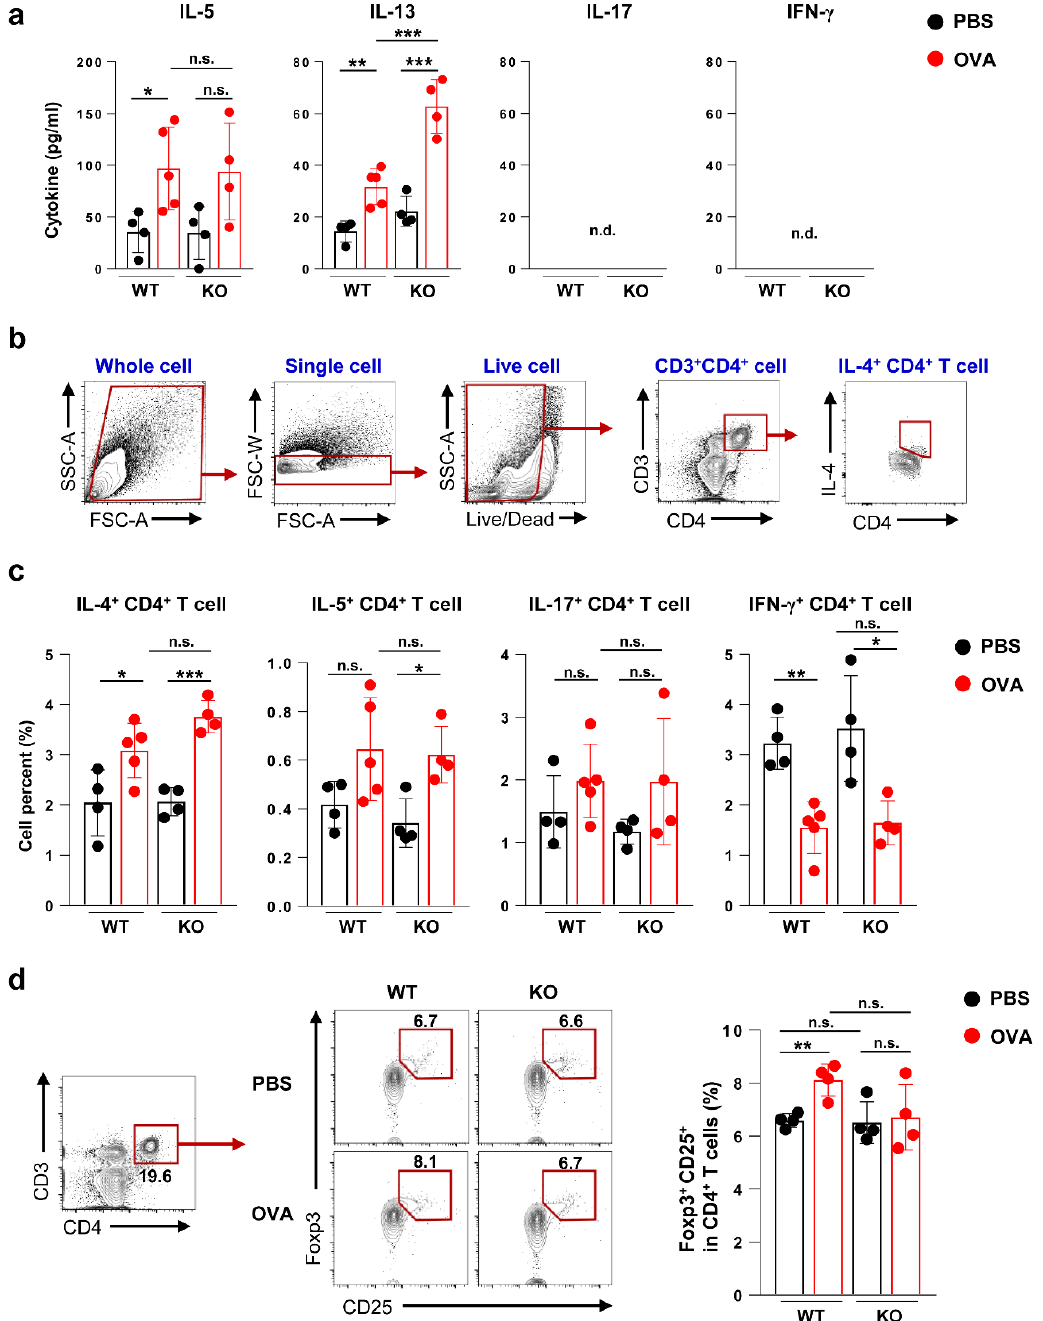
Figure 4. Cytokine profiles and analysis of T cell subpopulations in lungs of wild-type (WT) and Flt3 knockout (KO) mice. ( a ) Cytokines were measured using ex vivo recall assays with ovalbumin (OVA) protein (10 μg/mL) in isolated lung cells. ( b ) Representative flow cytometry plots for the examination of intracellular cytokines of CD4 + T cells in the lung. ( c ) Intracellular levels of interferon- γ (IFN- γ ), interleukin (IL)-4, IL-5, and IL-17 of CD4 + T cells in the lung were measured using flow cytometry after stimulation with OVA (10 μg/mL) for 2 h with GolgiStop. ( d ) CD4 + CD25 + Foxp3 + regulatory T cells (Treg) were gated from CD4 + T cells using flow cytometry. Data are representative of three independent experiments with four or five mice/group in each experiment. The results are expressed as the mean ± standard deviation. The significance of di ff erences was analyzed using an unpaired Student’s t -test. * p < 0.05, ** p < 0.01, *** p < 0.001. n.d., not